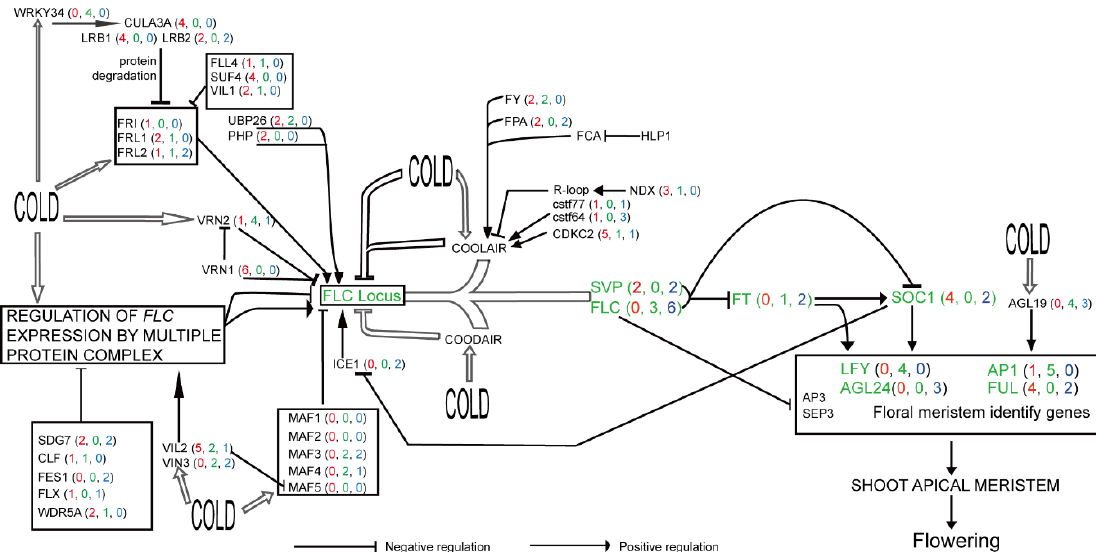
Figure 6. The flowering-time vernalization pathway in B. napus . This pathway was modified from a previous model [11]. Genes directly involved in the vernalization pathway in our study are marked in black, while genes belonging to the flowering-time integrator pathway but playing central roles in vernalization are marked in green. Values in parentheses, from left to right, represent the numbers of highly expressed genes (red), weakly expressed genes (green), and organ-specific genes (blue) in the same subfamily. The open arrows represent genes that could be induced by environmental changes and cold treatment.